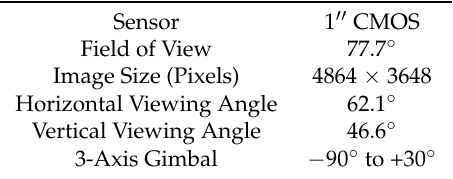
Table 1. Basic camera specifications for the DJI Phantom 4